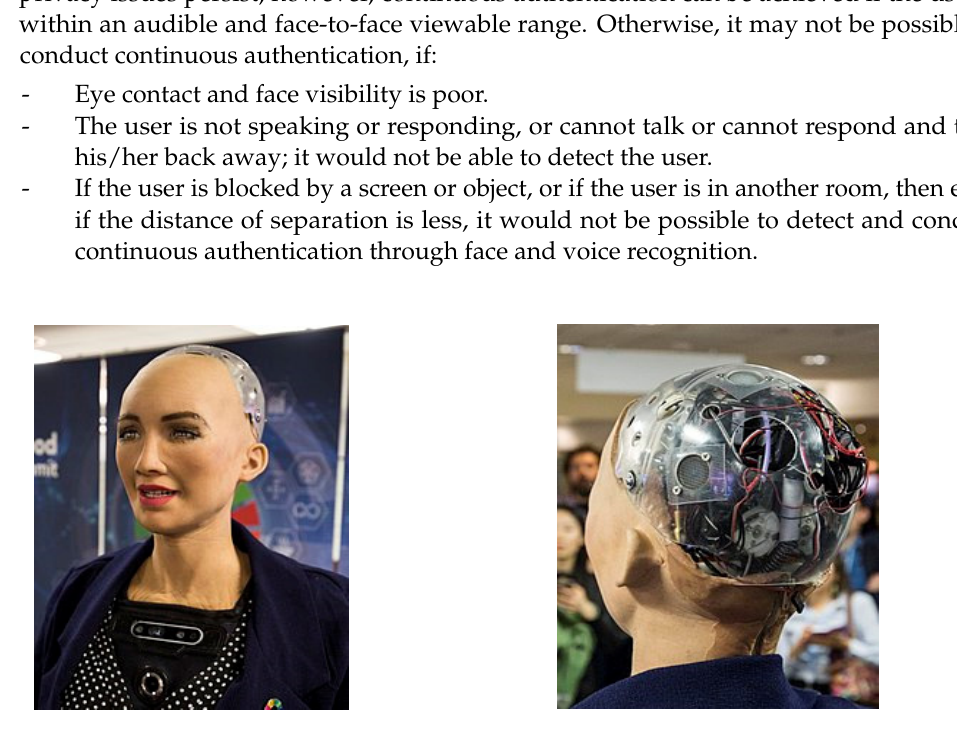
Figure 9. Sophia the Robot (https://www.hansonrobotics.com/(accessed on 11 October 2021)).